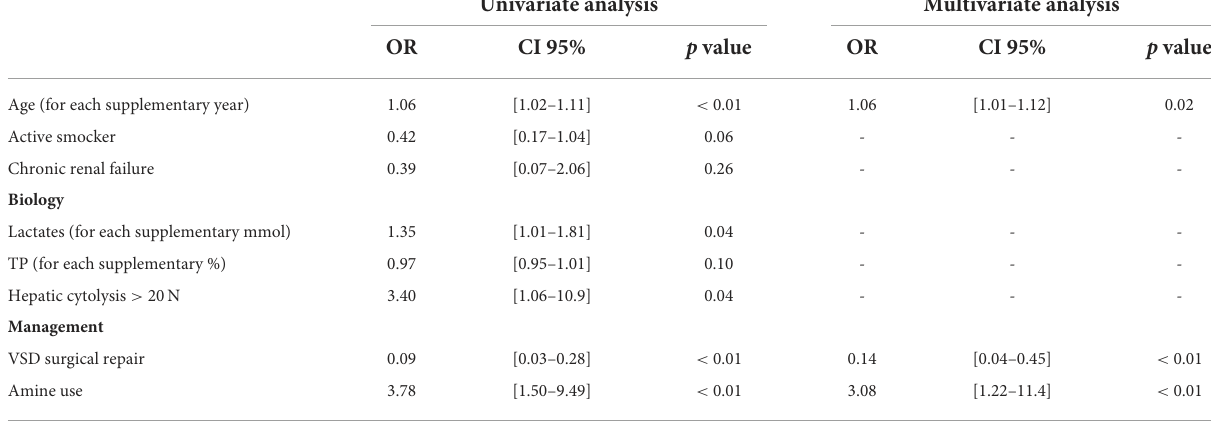
TABLE 2 Factors associated with in-hospital mortality by Cox regression